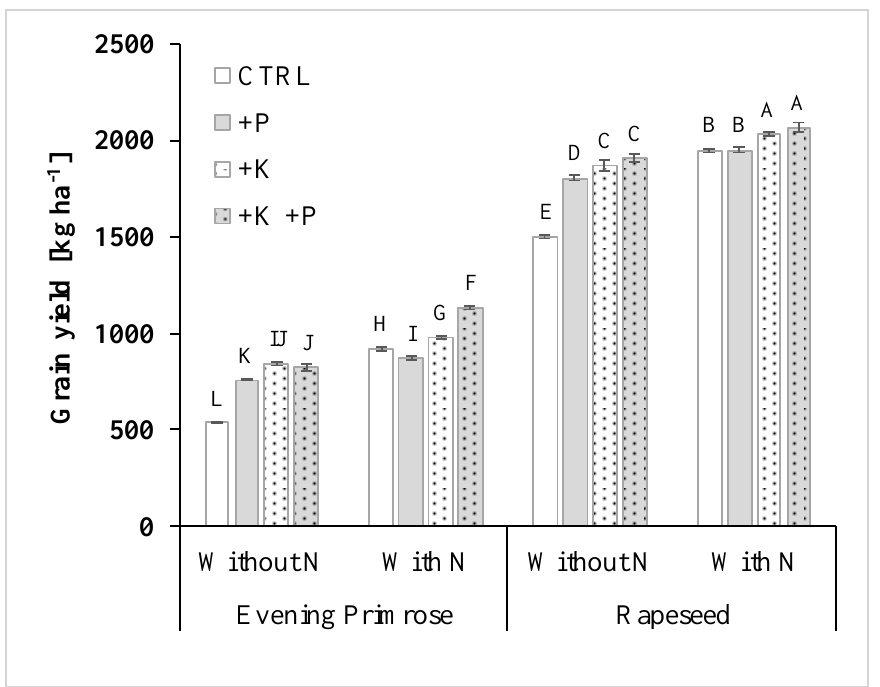
Figure 1. Least squares means (LSmeans) and standard error estimate of the LSmeans of the grain yield of Oenothera biennis L. local genotype (Evening Primrose) and Brassica napus L cv. serw 1 (Rapeseed) grown in 2 growing seasons in a P and K deficient soil and fertilized with 142.9 kg N ha − 1 , 171.4 kg K 2 O ha − 1 , or 36.9 kg P 2 O 5 ha − 1 . Means with a letter in common cannot be considered different according to a conservative Tukey-grouping applied to the p differences of the LSmeans. n = 6. Please note that error bars are standard error estimates of the LSmeans and not the computed standard error, which can be found in Supplementary Materials Table S1. CTRL indicates a lack of P and K applications.